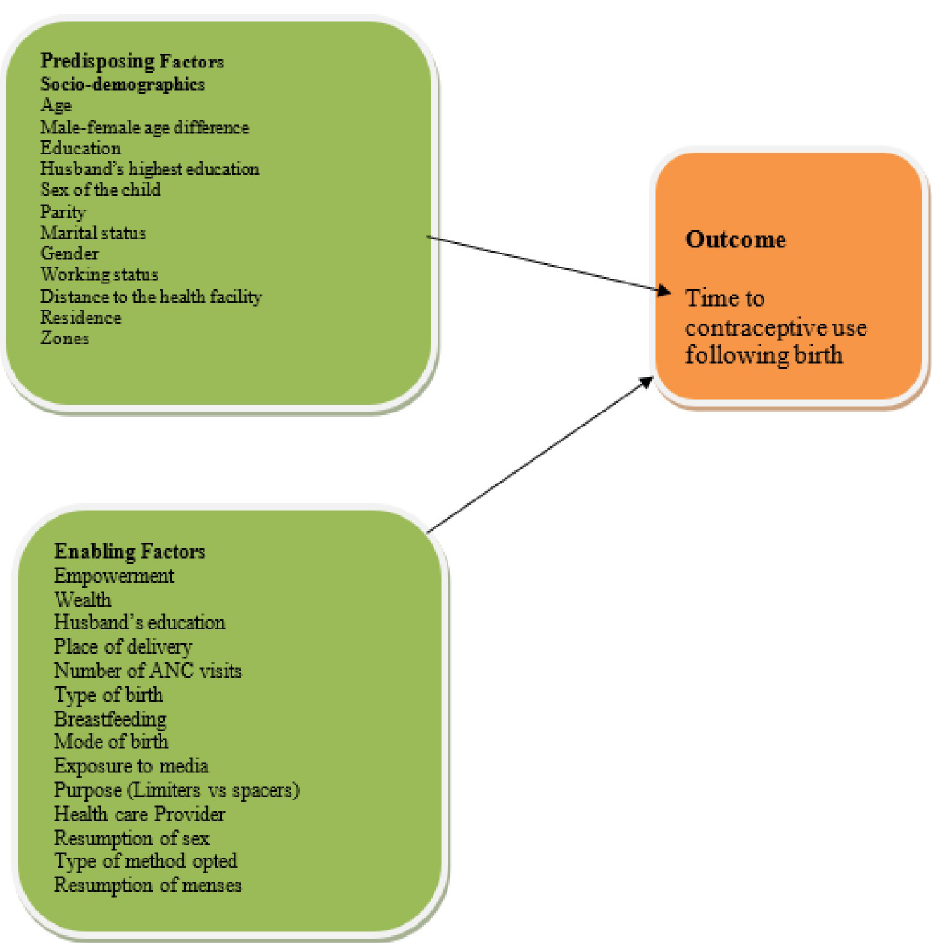
Fig 2. Conceptual framework on predictors of time to initiate postpartum